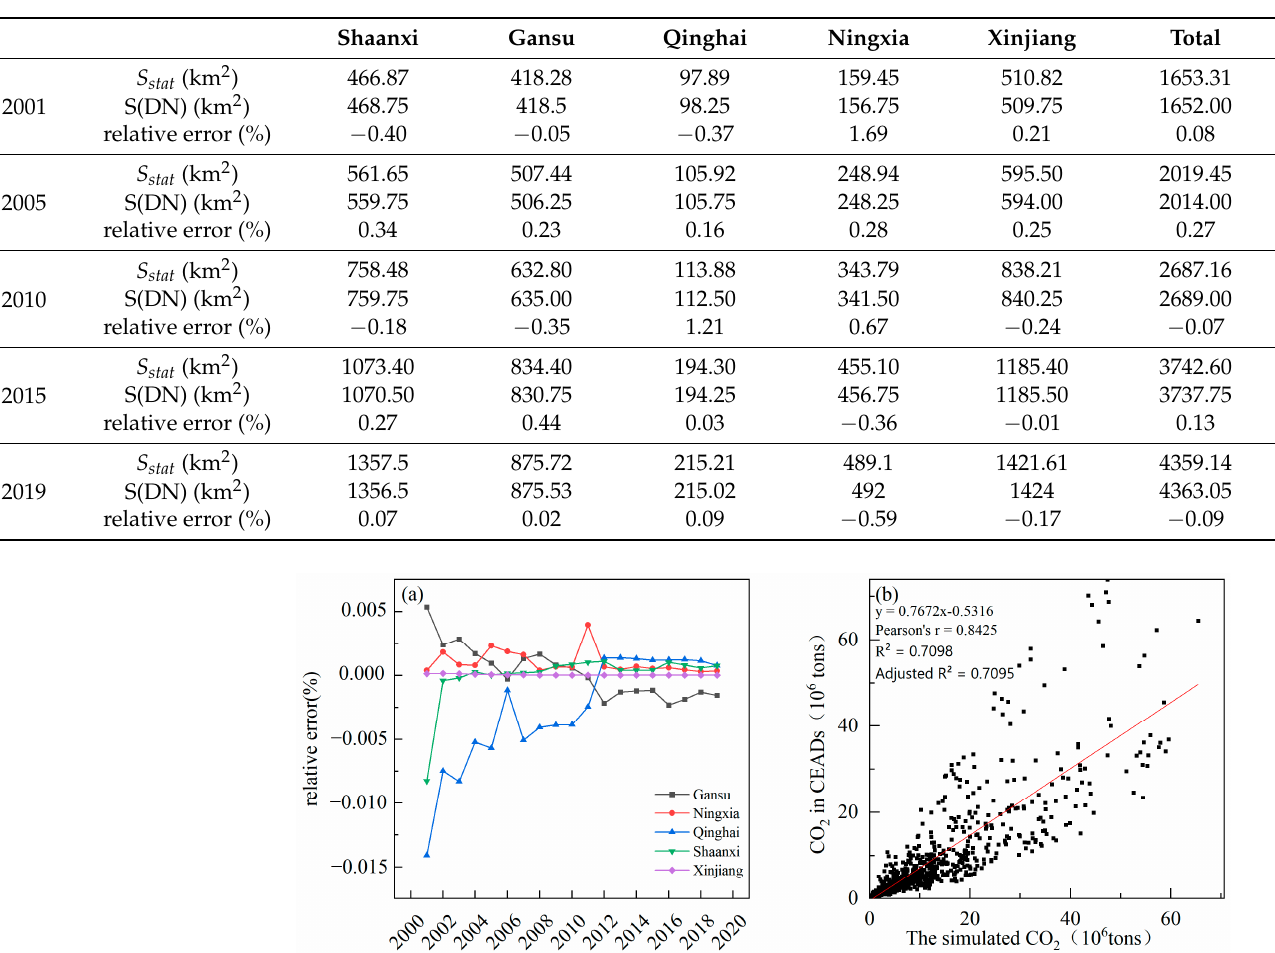
Table 3. The relative error between extracted urban built-up area and the actual built-up area.